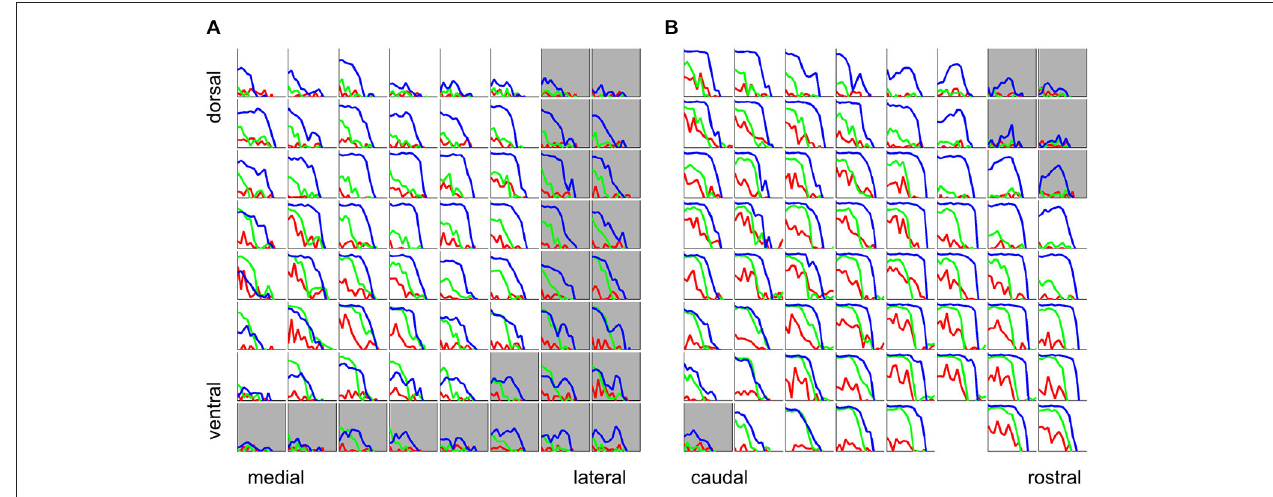
Tuning curves from recording sites inside the ICc are plotted against a white background, those outside the ICc are shown against a light gray background. Axis labels were omitted as they would be too small or too crowded to see, but all axes are scaled identically to Figure 5C , i.e., the abscissas cover a range of [ − 4,1] octaves re 500 Hz and the ordinates cover a range of [0, 1].